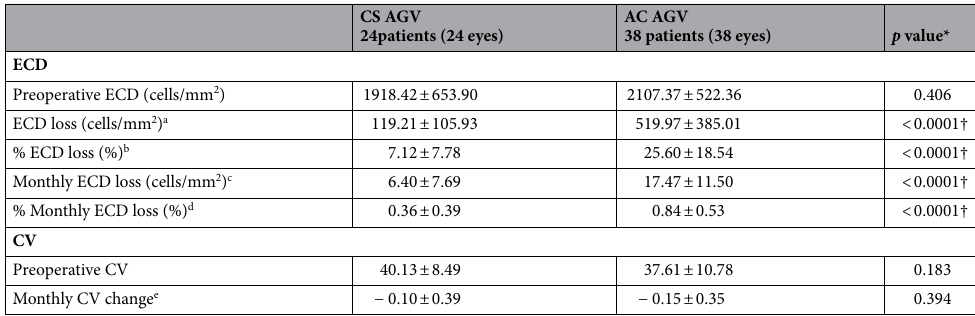
Table 4. Comparison of corneal endothelial cell measurements between the ciliary sulcus Ahmed valve and anterior chamber Ahmed valve groups. CS AGV ciliary sulcus Ahmed glaucoma valve, AC AGV